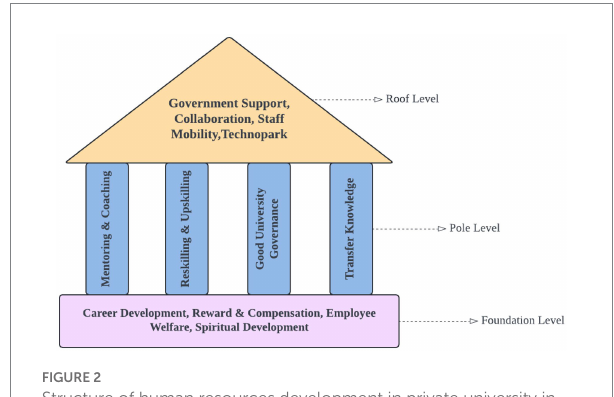
FIGURE 2 Structure of human resources development in private university in